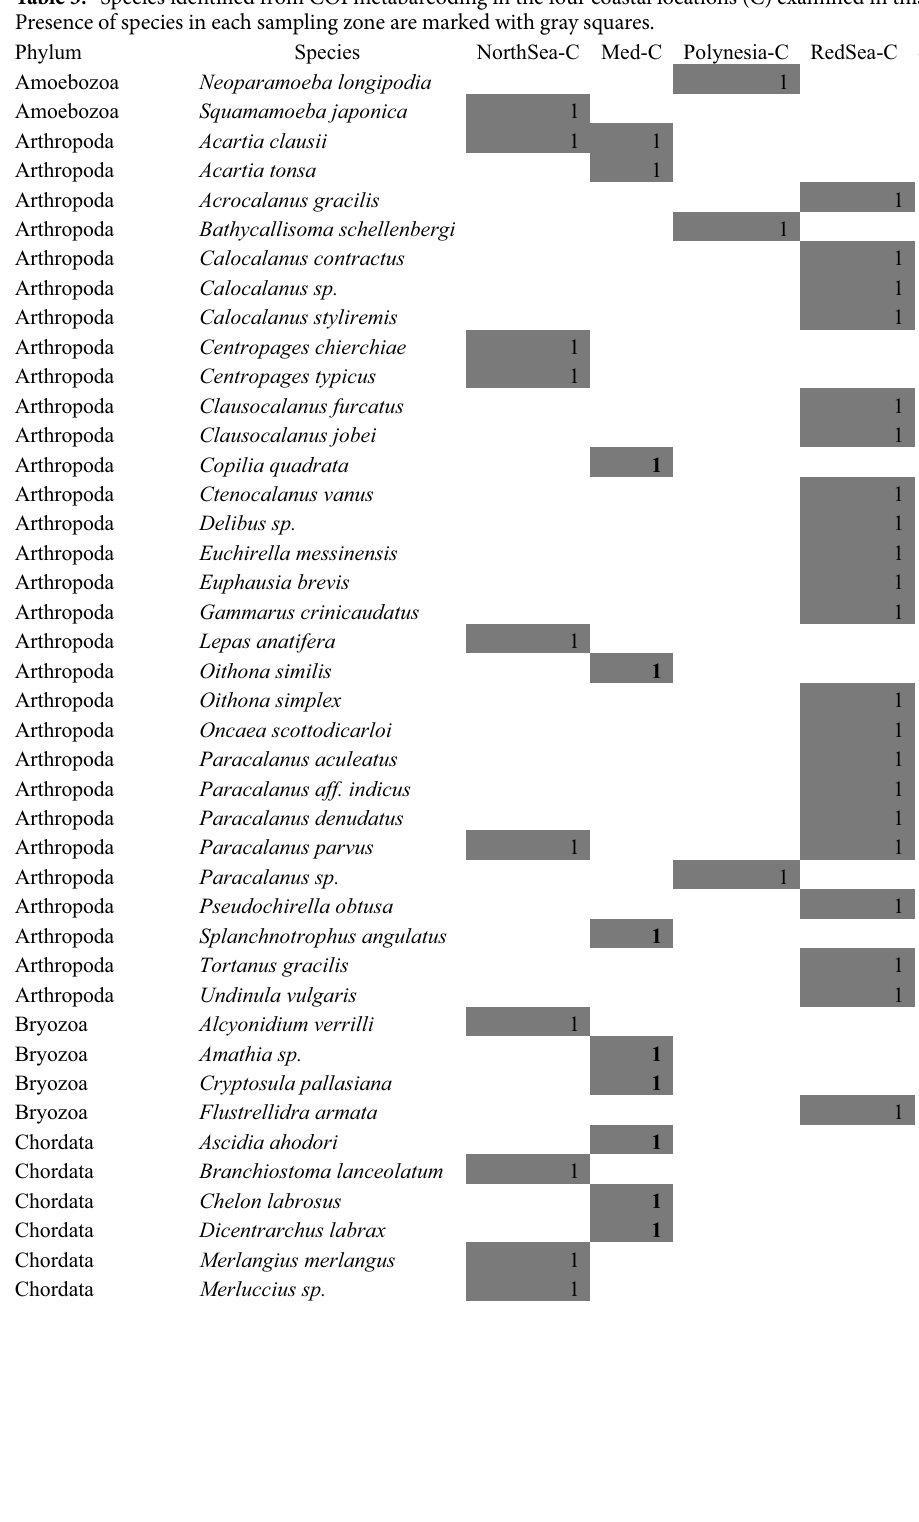
Table 3. Species identified from COI metabarcoding in the four coastal locations (C) examined in this study. Presence of species in each sampling zone are marked with gray squares.